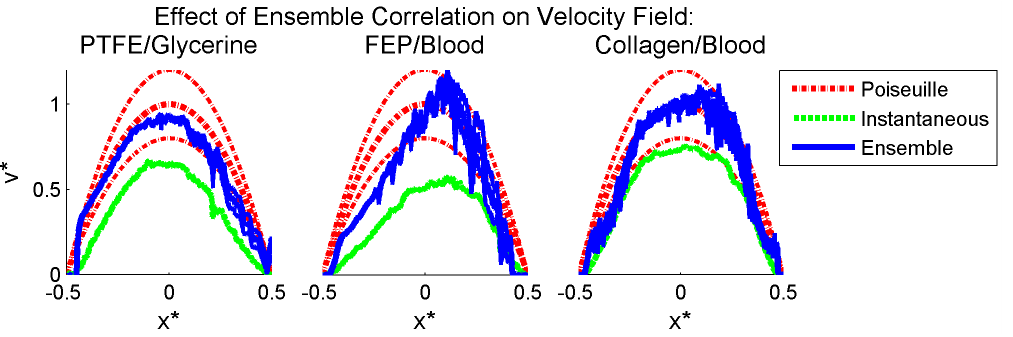
Figure 8. Effect of sum-of-correlation on PIV accuracy. Mean velocity profiles obtained using instantaneous (dashed green lines) and sum-of- correlation (solid blue lines) RPC applied to processed images are plotted with the volume-adjusted Poiseuille solution (dashed red lines) for each experimental case. The uncertainty based on measured flow rate and vessel diameter is plotted for the theoretical solution (upper and lower dashed red lines). The 95% confidence interval on the mean for the experimental data is not distinguishable from the mean. Left to right: glycerine-perfused PTFE, blood-perfused FEP, and blood-perfused collagen. Data shown is averaged in time for the instantaneous sets and along the length of the vessel for all sets and is normalized for each experimental case by the vessel diameter and theoretical maximum